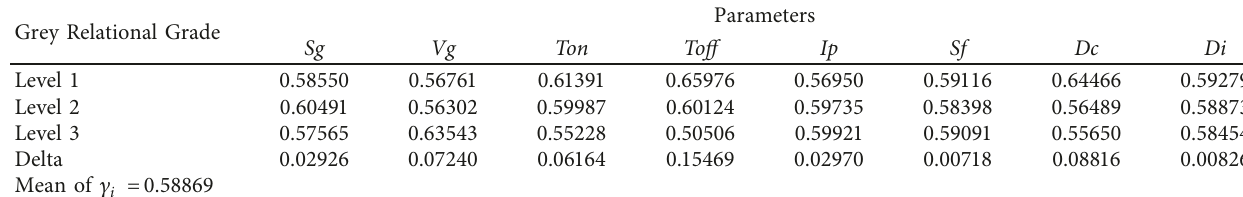
Table 15: Response table (mean) for grey relational grade.